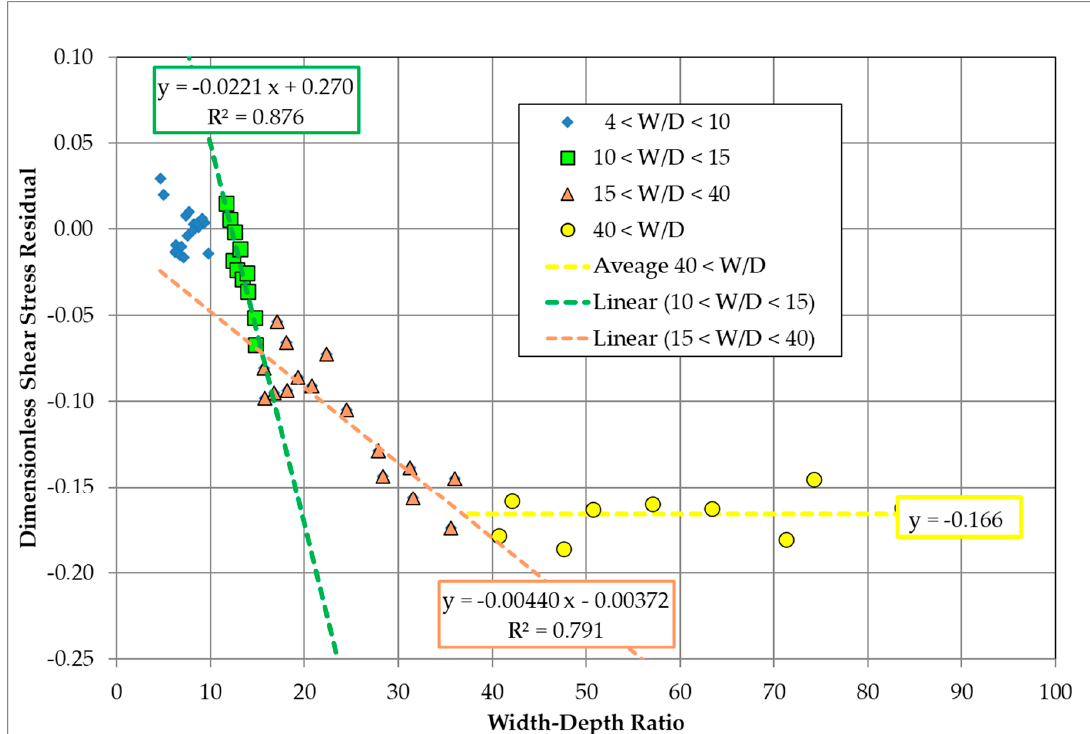
Figure 46. Residuals from 6 simulation sets between the maximum shear stress, computed by Equation (17), and the maximum shear stress simulated by the 3D model versus the channel width/depth ratio.